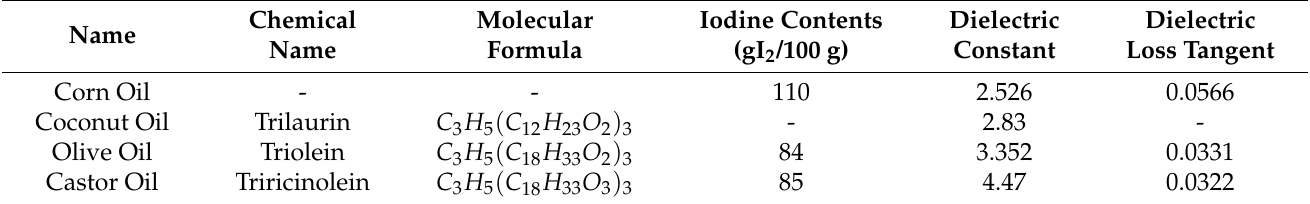
Table 2. Dielectric and chemical properties of OUT [42,47].